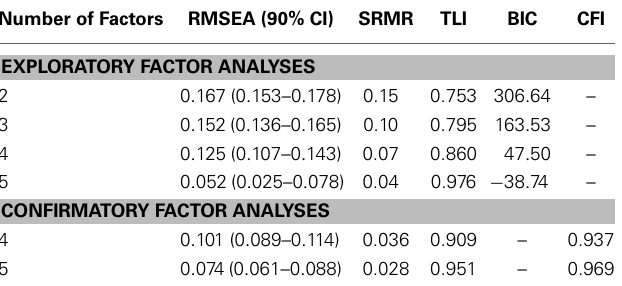
Table 2 | Results of analyses of the measurement model. Number of Factors RMSEA (90% CI)